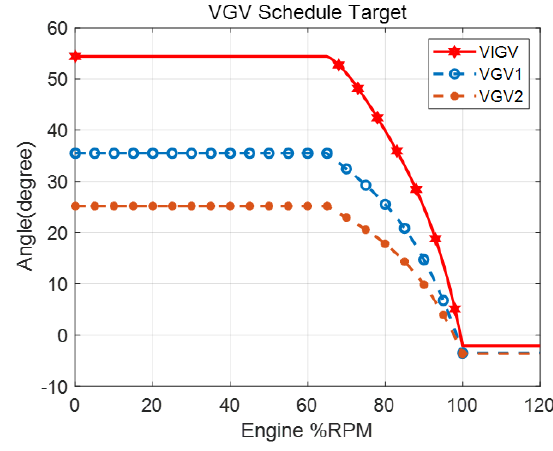
Figure 11. VGV scheduling target.